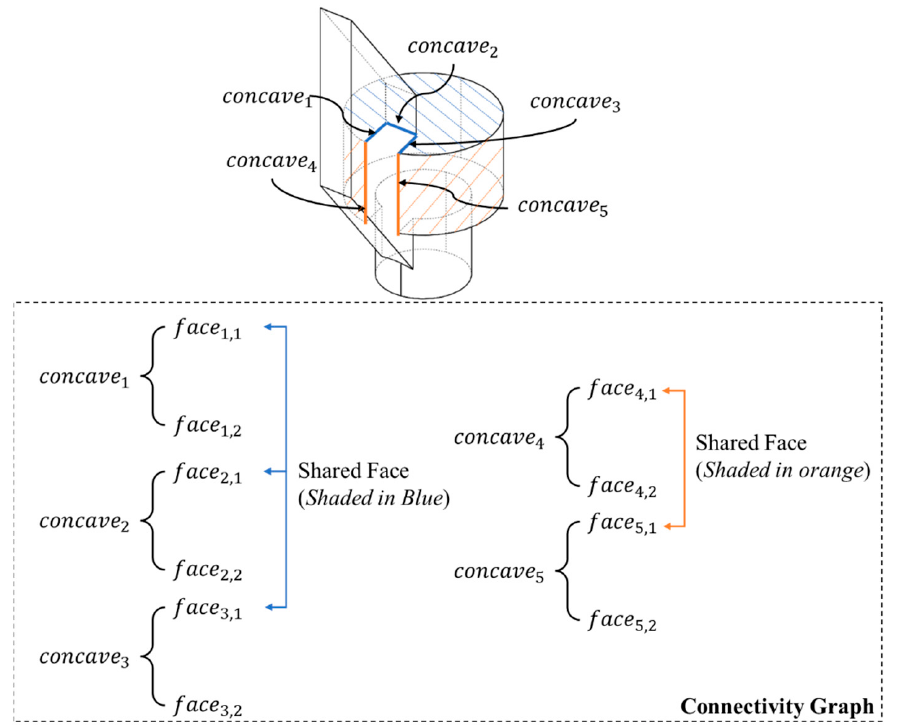
Figure 6. Connectivity graph generation by Algorithm 1.